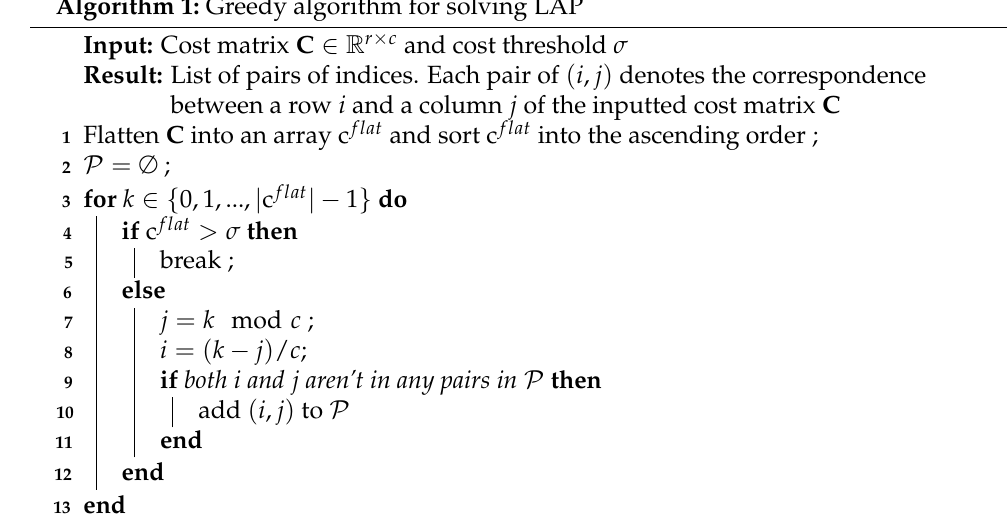
Algorithm 1: Greedy algorithm for solving